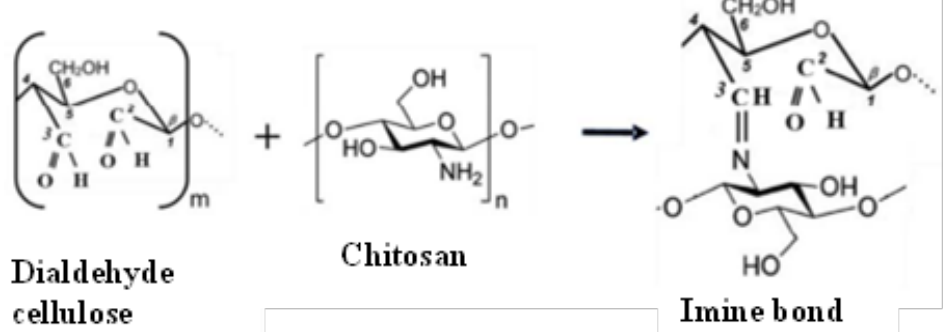
Figure 3. Formation of crosslinking between dialdehyde cellulose and chitosan.